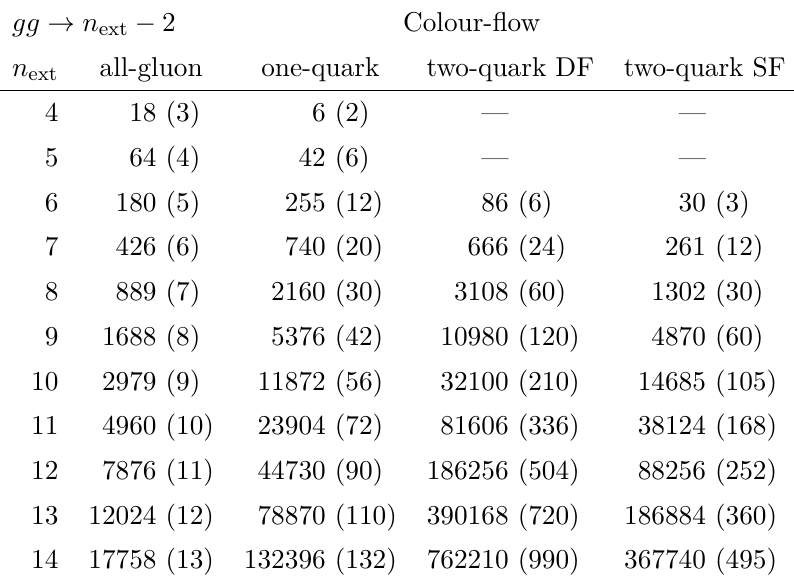
Table 7 . Number of non-zero elements in the colour matrix at NLC and at LC (in parenthesis) including the reduction due to the phase-space symmetrisation, for gg initial states for all-gluon, one- quark-pair and two-quark-pair (same-flavour (SF) and distinct-flavour (DF)) processes for various numbers of final-state particles ( n 2 ) in the colour-flow ext −